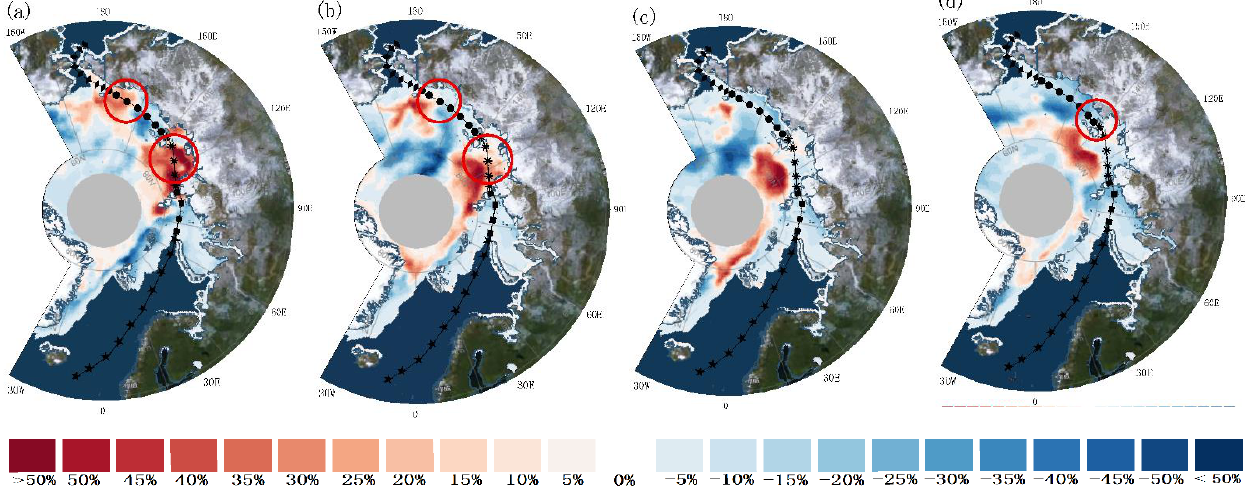
Figure 8. The anomalous distribution of sea ice concentration from July to October 2016 ( a – d ). (The outliers are based on the period from 2011 to 2020, the red circles represent the special